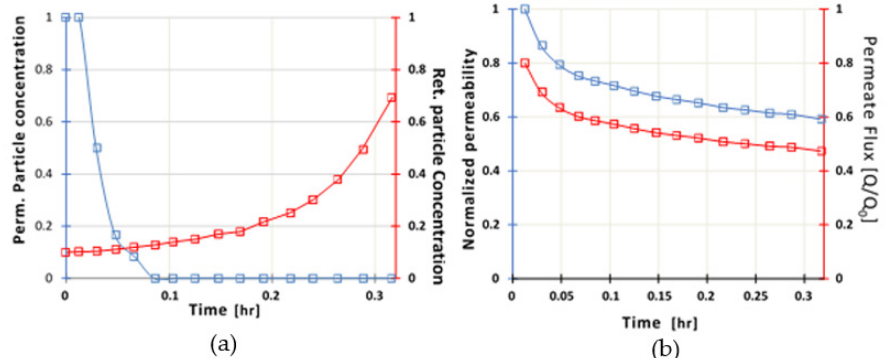
Figure 9. ( a ) Normalized particle concentration in the permeate (blue line) and in the retentate (red line) streams ( b ) Normalized Permeability (blue line) and normalized permeate flux (red line), as a function of filtration time for C 0 = 70NTU.